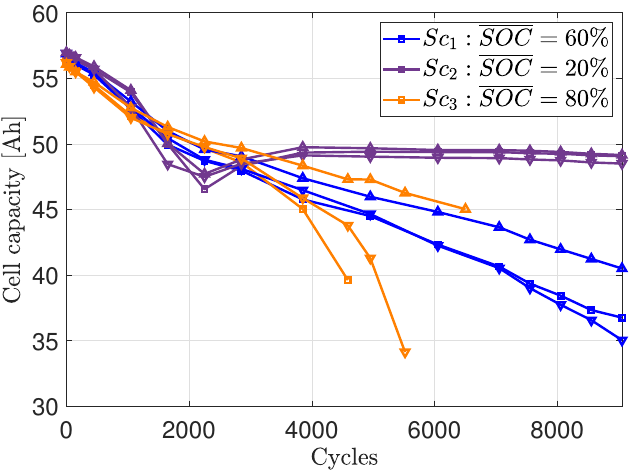
Figure 10. Capacity course vs. cycles during the long-term